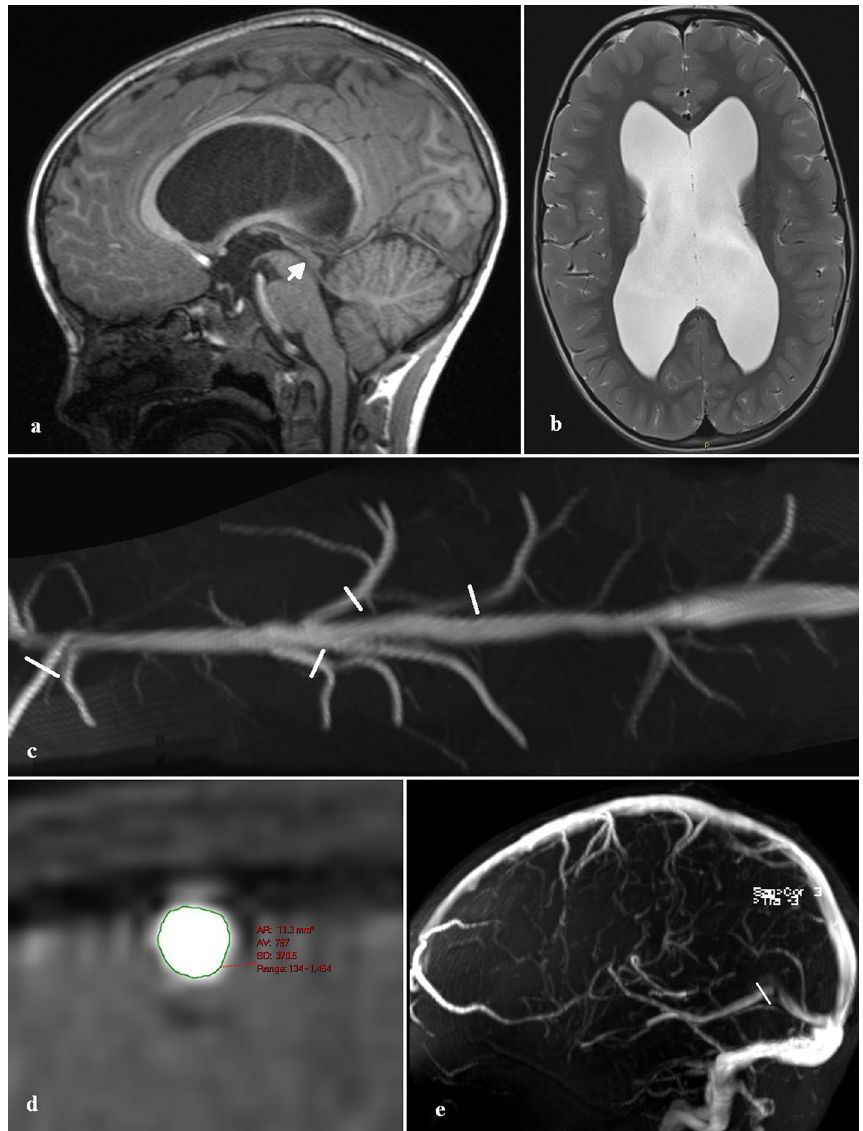
Figure 3. Site of vein measurements in a child with obstructed hydrocephalus. ( a ) sagittal T1 image of patient 2 showing the obstructed aqueduct of Silvius (arrow). ( b ) Axial T2 image showing the ventricular dilatation. ( c ) Curved maximum intensity projection image obtained from the MRV data orientated along the course of the superior sagittal sinus (outflow towards the right) showing the site and orientation of the BCV measurements (white lines). ( d ) MRV reconstruction of a cortical vein showing an area measurement. ( e ) MRV reconstruction showing the site of the vein of Galen measurement (white